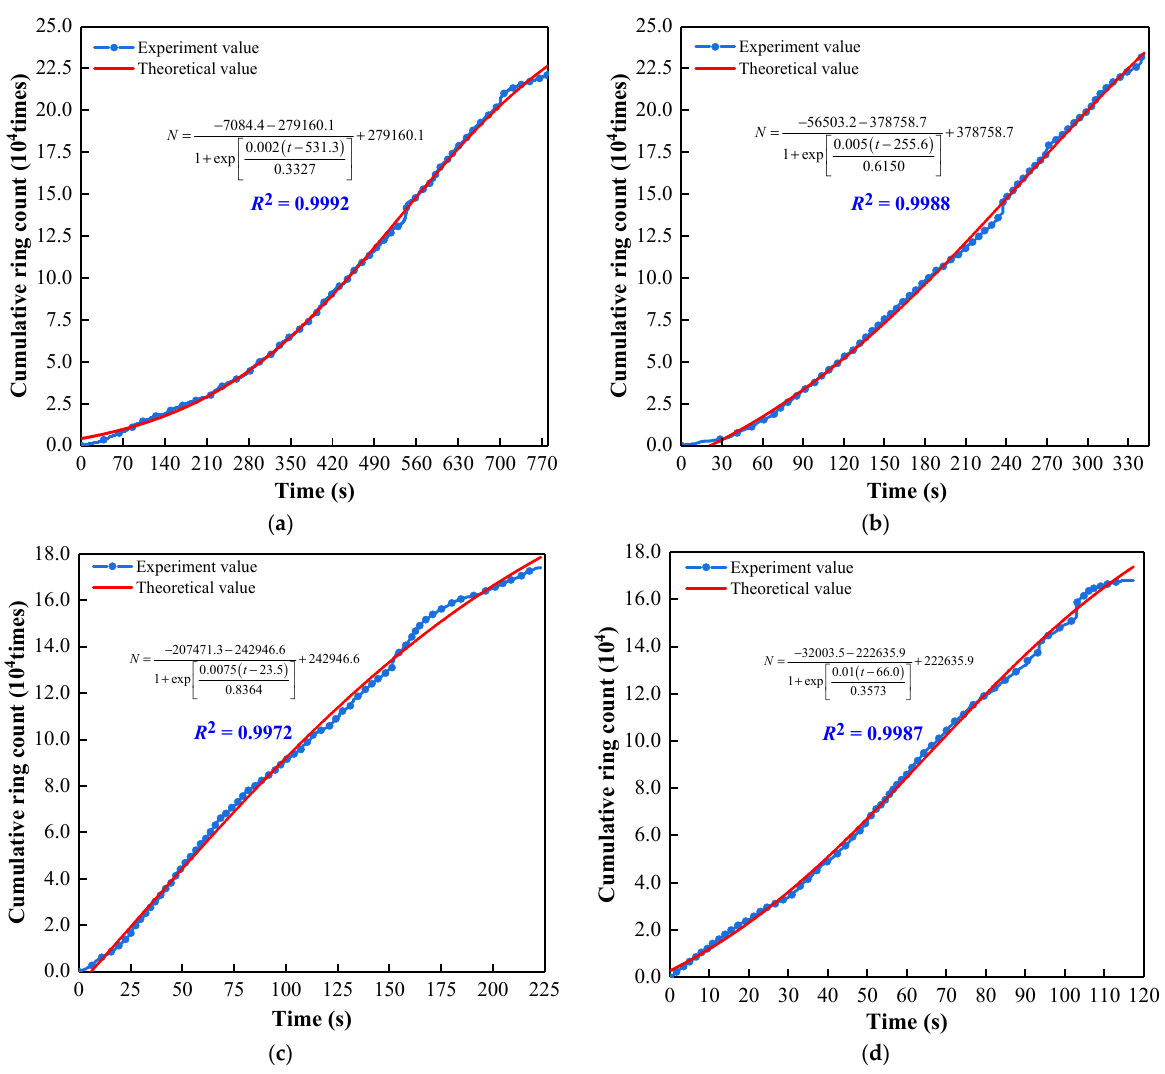
Figure 10. Fitting of the AE cumulative ringing count with time. ( a ) 0.002; ( b ) 0.005; ( c ) 0.0075; ( d ) 0.01. Formula: σ is nominal stress, σ * is effective stress, E is the elastic modulus of the filling body, and ε is